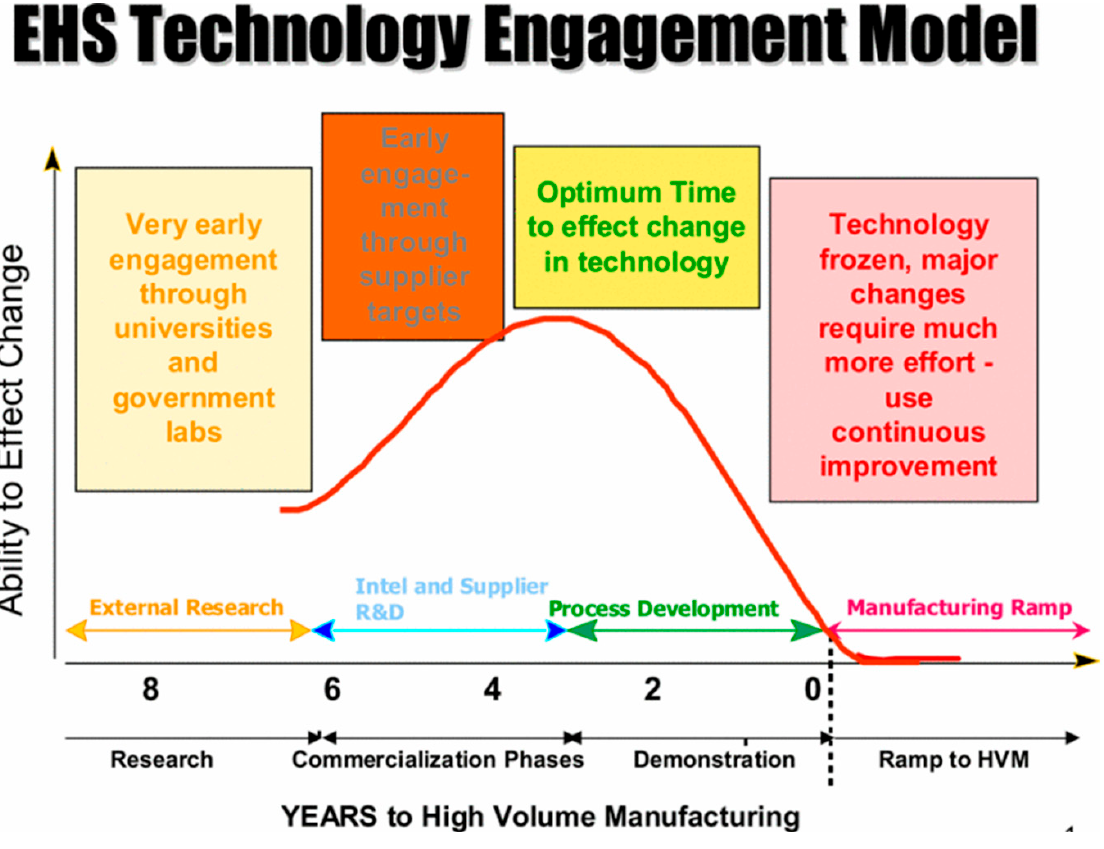
Figure 8. Environment, Health and safety (EHS) Technology Engagement Model [40]. This figure emphasises how far ahead manufacturing ramp engineers and designers must work to integrate sustainable practices into new